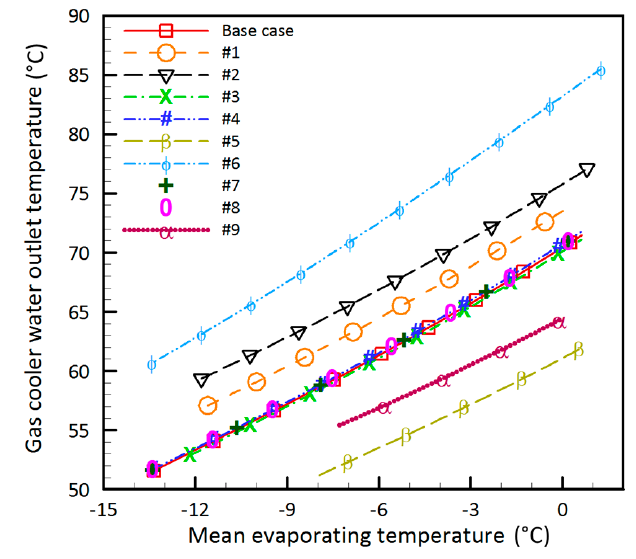
Figure 11. Water outlet temperature ( T out_water ).